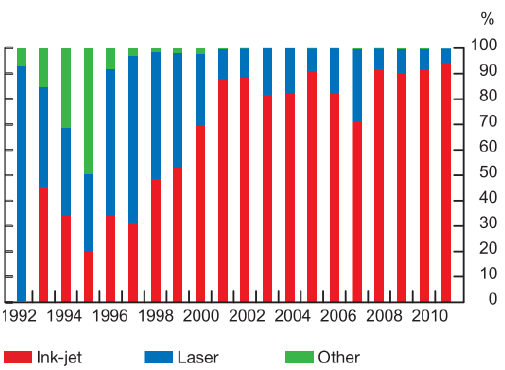
Figure 5. Share of counterfeits by printing method—Canadian dollar. New Israeli Shekel (NIS) banknotes are also forged. According to unofficial estimates, about 250M NIS are forged each year. We analyzed authentic and counterfeit 200 NIS banknotes (which is the most popular banknote in Israel, with ca. 290 million bills in 2018) [29].